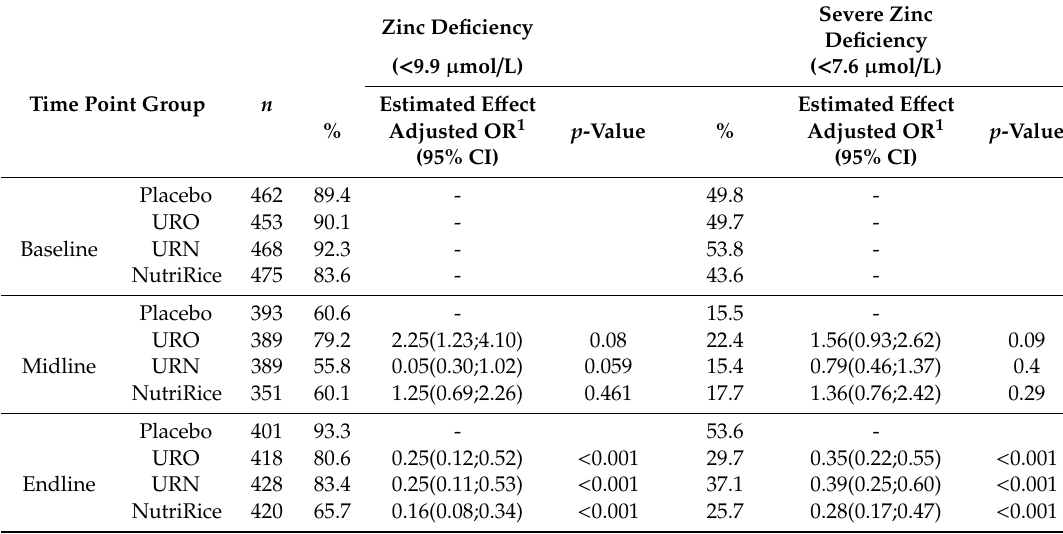
Table 5. Prevalence of zinc deficiency of participating children after three and six months of interventic.